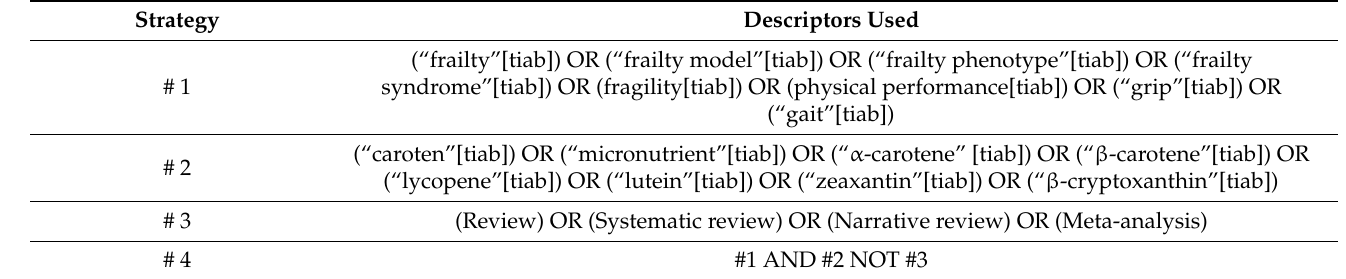
Table 1. Search strategy used in the US National Library of Medicine (PubMed) and Medical Literature Analysis and Retrieval System Online (MEDLINE) and adapted to the other sources, according to selected